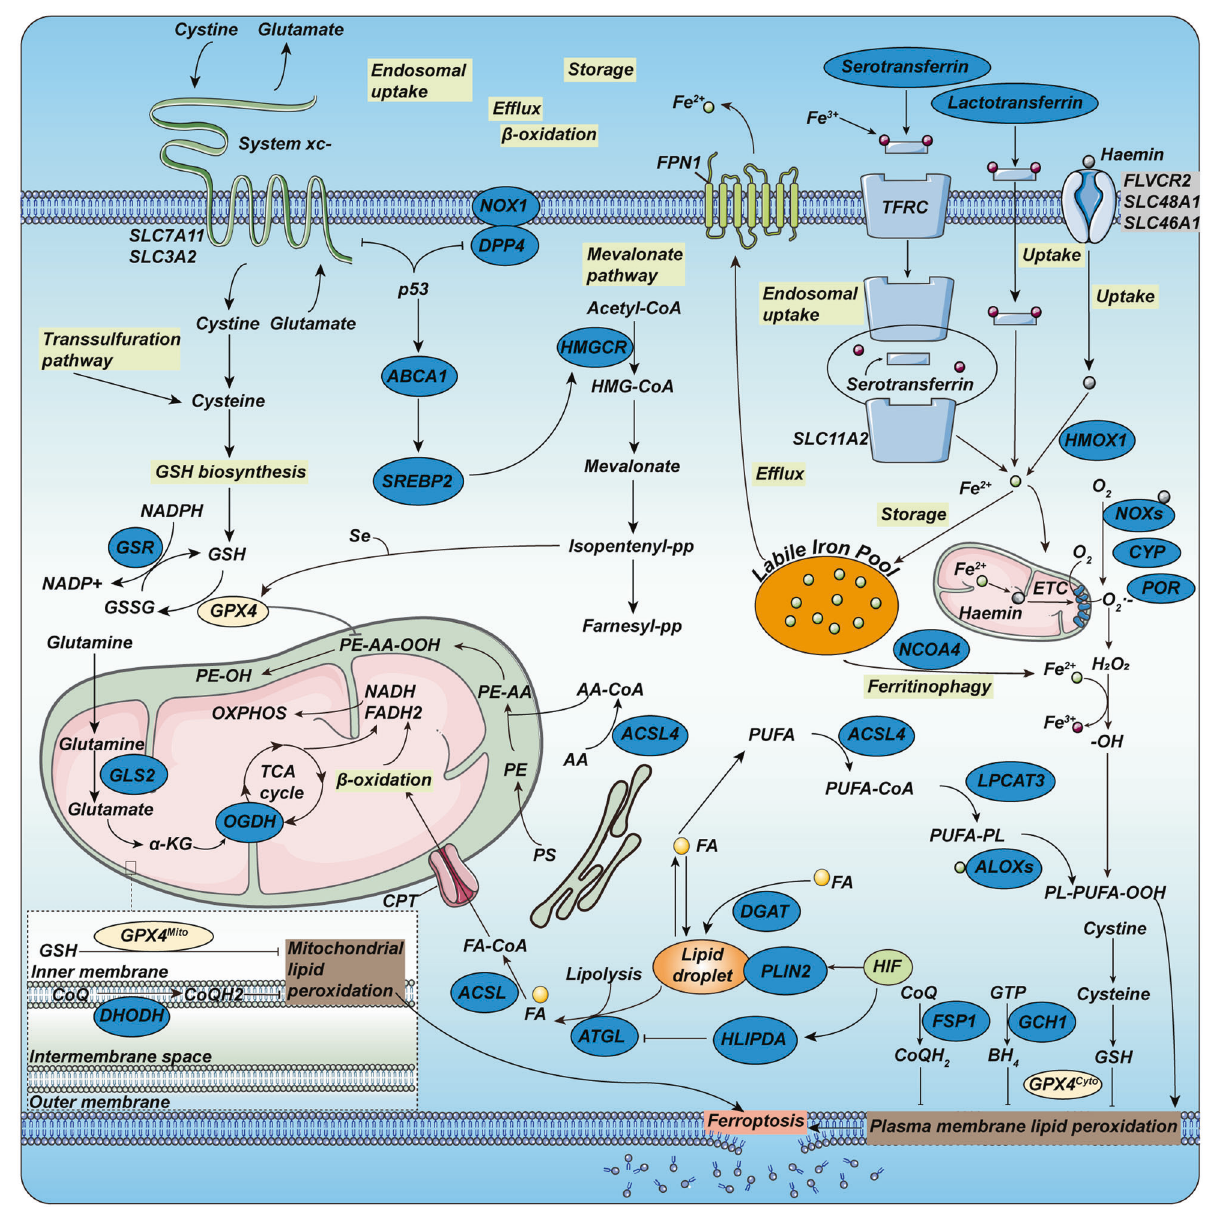
Fig. 1 Molecular mechanisms of ferroptosis. Ferroptosis is typically triggered by iron-dependent lipid peroxidation. The cystine/glutamate transporter (also known as system xc-) imports cystine into cells with a 1:1 counter-transport of glutamate. Once inside the cells, cystine can be oxidated into cysteine, which is used to synthesize GSH. Taken as a reducing cofactor, GSH is in the reaction of reducing lipid hydroperoxides to lipid alcohols under the capability of glutathione peroxidase GPX4. Transsulfuration pathway is involved in supporting the availability of cystine and reduced GSH. Respectively, the mevalonate pathway generates a series of biomolecules and then drives ferroptosis. Several proteins (including serotransferrin, lactotransferrin, Transferrin receptor (TFRC), ferroportin 1 (FPN1), nuclear receptor co-activator 4 (NCOA4)) control ferroptosis through the regulation of iron metabolism. Fe 3 + could be internalized into cells through three distinct pathways including lactotransferrin, haemin and serotransferrin-TFRC-SLC11A2 pathway, during which Fe 3 + is reduced and storage in the liable iron pool. Cells have evolved at least four systems inhibiting ferroptosis with different subcellular localizations to decrease lipid peroxides. The GPX4-GSH system can collaborate with FSP1-CoQH2 system on the plasma membrane and can also cooperate with DHODH-CoQH2 system on mitochondrial membrane. Of late, the impact of the hypoxia-inducible factor (HIF) system on fatty acid (FA) metabolism has been depicted. α - KG α -ketoglutarate, AA arachidonic acid, ABCA1 ATP- binding cassette subfamily A member 1, ACSL4 Long- chain fatty acid – CoA ligase 4, ATGL adipose triglyceride lipase (also known as PNPL A2), ALOXs Arachidonate lipoxygenases, CoQ coenzyme Q10, CPT carnitine palmitoyl transferase, DGAT diacylglycerol O- acyltransferase, DPP4 dipeptidyl peptidase 4, ETC electron transport chain, ER endoplasmic reticulum, FLVCR2, FPN1 ferroportin 1 (also known as SLC40A1), GLS glutaminase, GSR glutathione disul fi de reductase, GSSG glutathione disul fi de, HILPDA hypoxia-inducible lipid droplet- associated, HMGCR HMG-CoA reductase, LOX lipoxygenase, LPCAT lyso-phosphatidylcholine acyltransferase, NCOA4 nuclear receptor co-activator 4, NOX1 NADPH oxidase 1, OGDH oxoglutarate dehydrogenase, OXPHOS oxidative phosphorylation, PE phosphatidylethanolamine, PLIN2 perilipin 2, PS phosphatidylserine, SREBP2 sterol regulatory element binding protein 2, system xc- cystine – glutamate antiporter, TFRC transferrin receptor, GCH1 GTP cyclohydrolase 1, HMOX1 Heme oxygenase, SLC48A1 solute carrier family 48 member 1, SLC46A1 solute carrier family 46 member 1, SLC7A11 solute carrier family 7 member 11, SLC3A2 solute carrier family 3 member 2, SLC11A2 solute carrier family 11 member